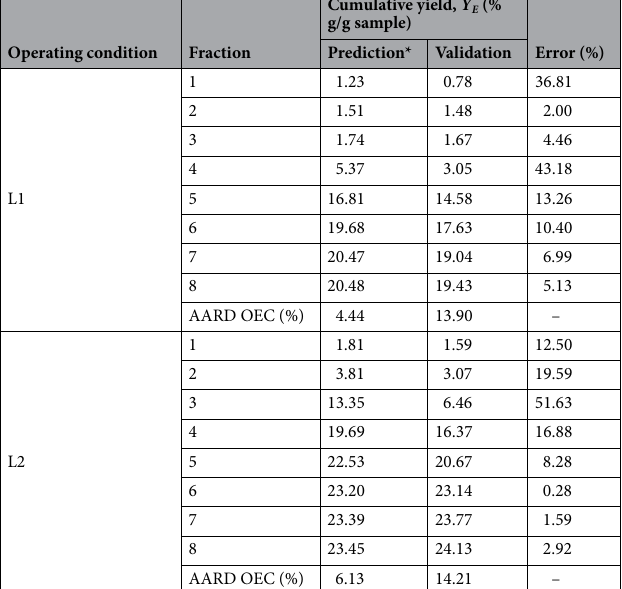
Table 8. Fraction and cumulative extraction yield for scale-up prediction and validation of 0.5 kg feed sample. L1: P = 200 bar, T = 60 °C, co-solvent = 50% ethanol–water with 10% (v/v) concentration, L2: P = 262